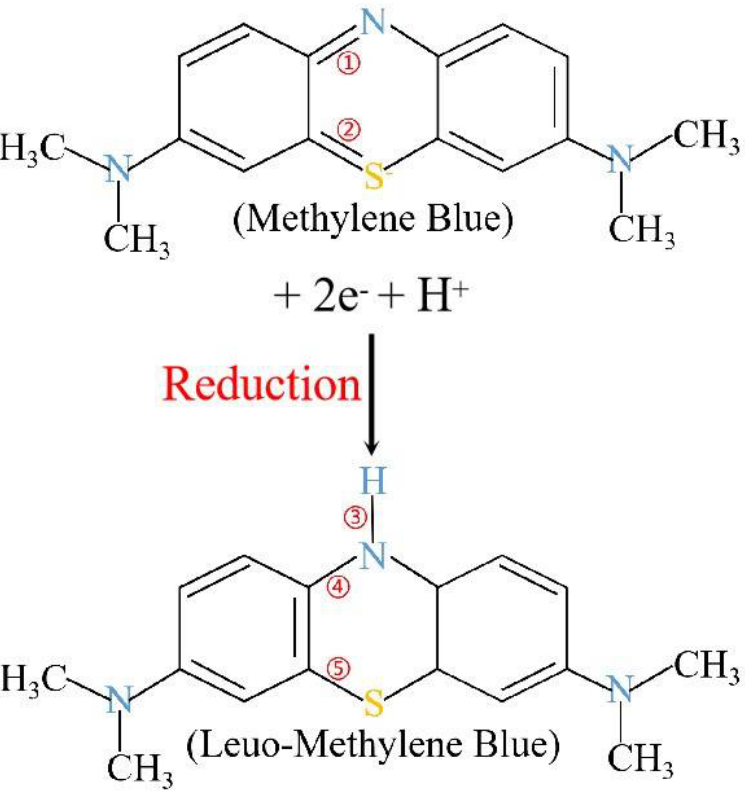
Figure 12. Decolorization reaction of MB.